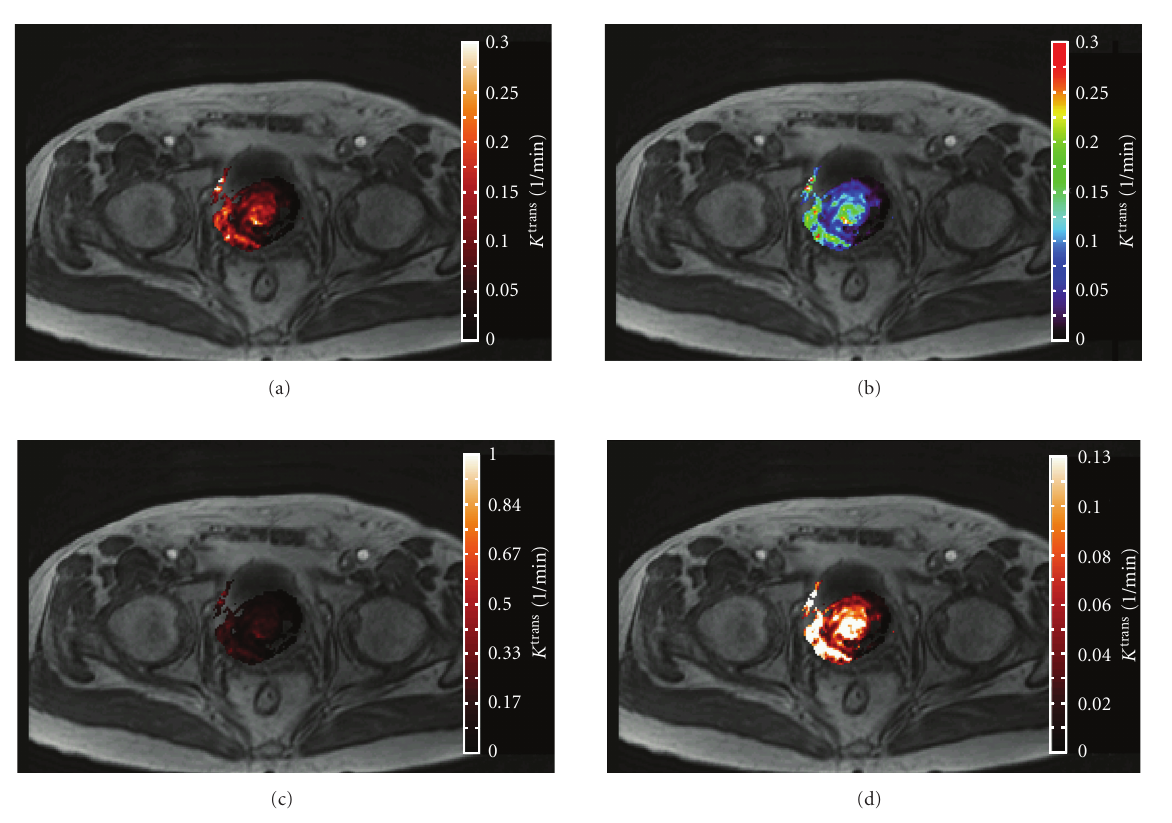
Figure 2: Visual assessment of tumor vascular heterogeneity on a pseudocolor map is inherently subjective: the same parametric map of the pharmacokinetic parameter K trans is visualized as pseudocolor overlays with di ff erent display ranges and color schemes on a morphologic image in a bladder cancer patient. Compared to the single color scheme ((a), “blackbody radiation”), the multicolor scheme “rainbow” in (b) exaggerates subtle di ff erences in K trans near color boundaries, creating artificial structures in the pseudocolor map. If the display range is chosen too large, the parametric map is perceived as being more “homogeneous” due to underrepresentation of the spatial variation (c). A small display range, on the other hand, tends to exaggerate the size of the “hotspot”, which may lead to an erroneous characterization of the disease